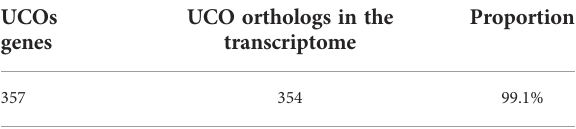
TABLE 2 Transcriptome gene capture of ultraconserved single copy genes.